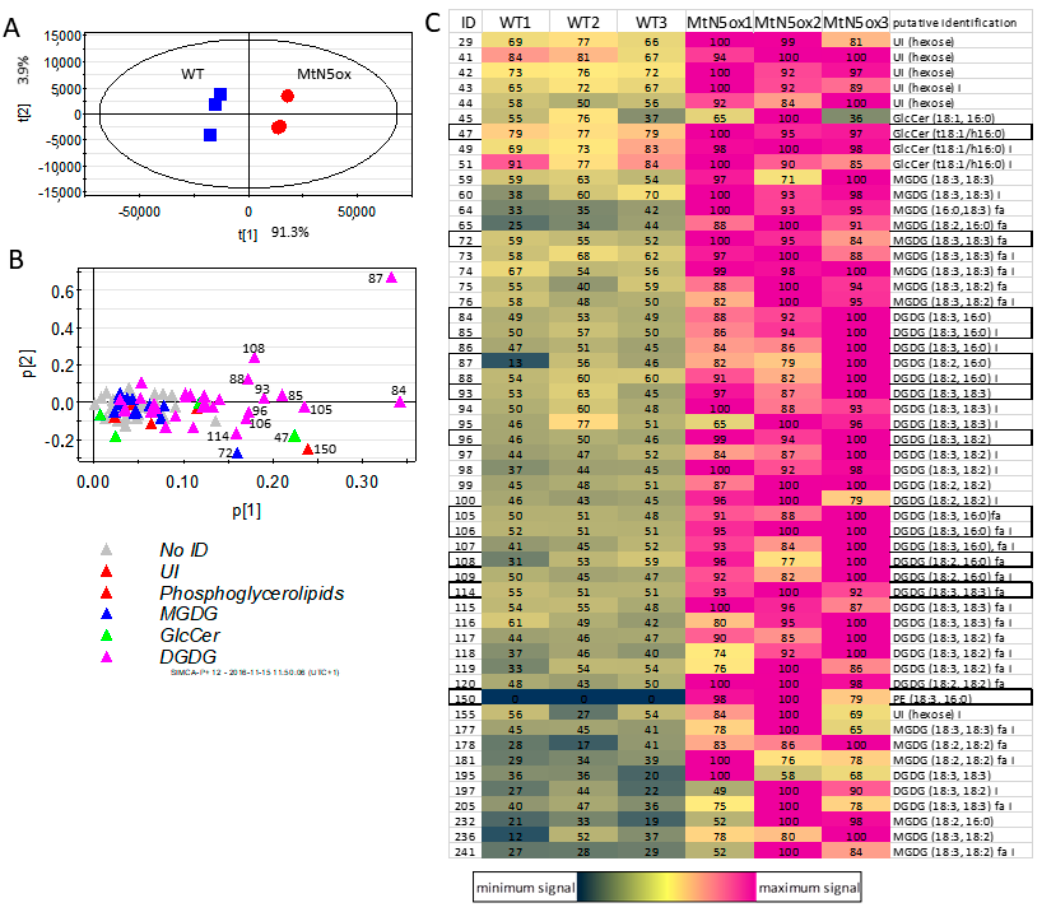
Figure 4. Principal Component Analysis (PCA) score plot ( A ) and loading plot ( B ) of WT and MtN5ox roots. ( C ) heat map (individual row-based) of signal intensity (in arbitrary units) of annotated lipid ( m/z features). WT = roots from wild type control plants; MtN5ox = roots from MtN5 overexpressing plants. The lipids labelled in the PCA loading plots are outlined in the heat map. UI, unidentified hexose-containing lipids; MGDG, Monogalactosyldiacylglycerol; GlcCer, Glucosyl Ceramide; DGDG, Digalactosyldiacyl glycerol.